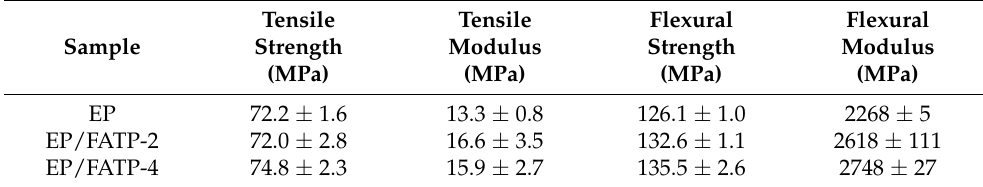
Table 9. Tensile and flexural properties of the pure EP and the